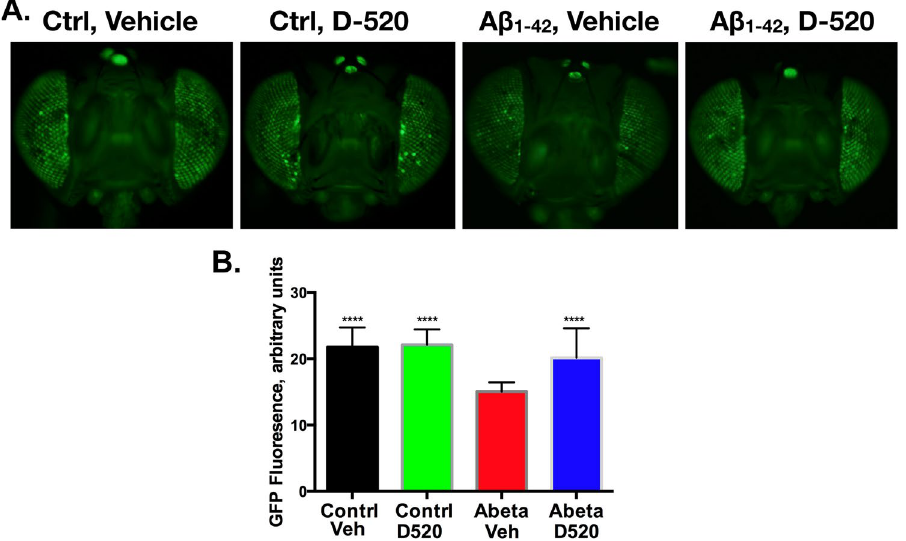
Figure 8. ( A ) Representative images of fly eyes expressing, or not, A β 1–42 in fly eyes, driven by the GMR-Gal4 driver. Flies were 14 days old and were either fed with the vehicle control (ultrapure water) or D-520 (1 mg/ mL dissolved in ultrapure water) for 14 days, at which time heads were dissected, imaged and quantified, as summarized in ( B ). Control: GMR-Gal4 driver and UAS-CD8-GFP in the absence of A β 1–42 . ( B ) Shown in histograms are GFP fluorescence means − / + standard deviation. Statistical analyses were conducted with ANOVA. *** P < 0.001 comparing columns 1, 2 and 4 to column